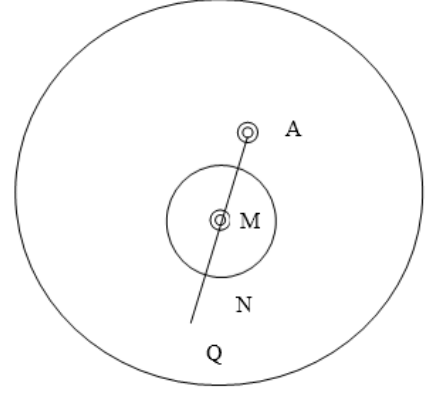
Figure 4. Circular zone and radio-circle embedding.